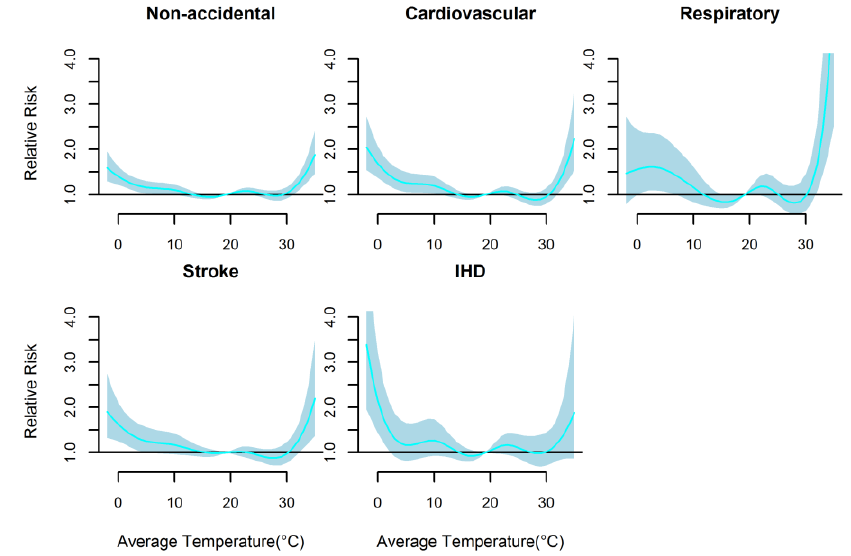
Figure 2. The non-linear effects of mean temperature on cause-specific mortality at lag 0–21, using a DLNM model with 6 df natural cubic spline for temperature and 4 df for lag.